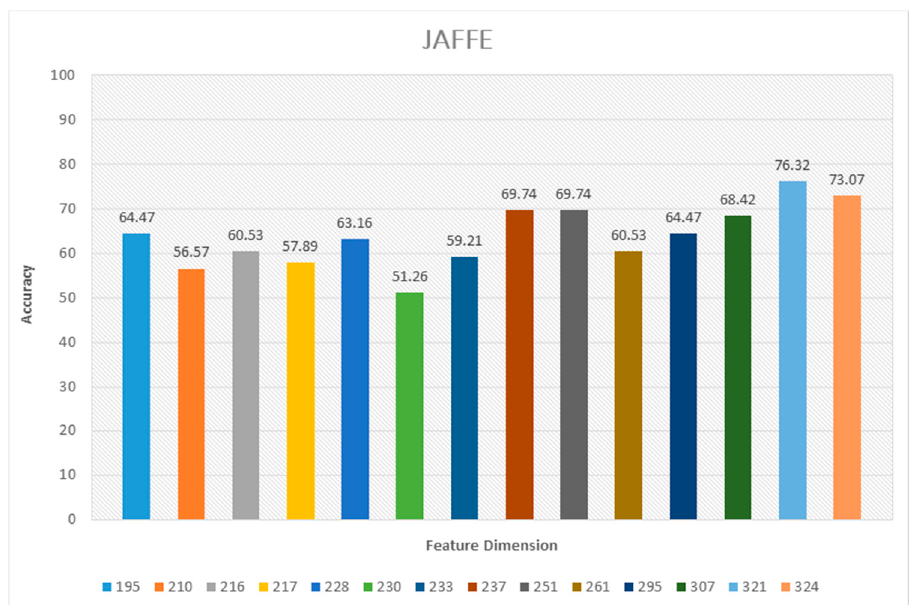
Figure 7. Graphical representation of the dimensions and accuracy scores (%) of the reduced-feature subsets in HM for PHOG-based feature vector extracted from images of dimension 32 × 32 in the JAFFE dataset. Distinguishable colors denote different feature dimensions of the reduced-feature subsets.